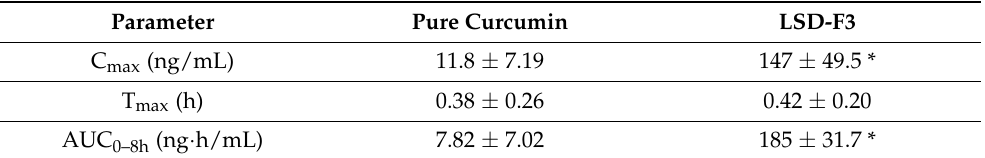
Table 3. Pharmacokinetic parameters following an oral administration of curcumin in different formulations to rats (Mean ± S.D, n =